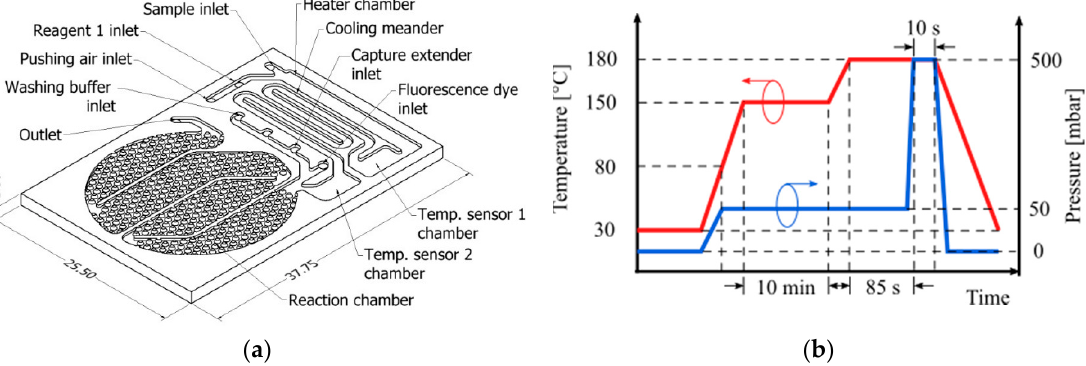
Figure 1. ( a ) Description of the manufactured biosensor. Dimension in milimeters. ( b ) Diagram of the applied hot embossing process parameters vs.